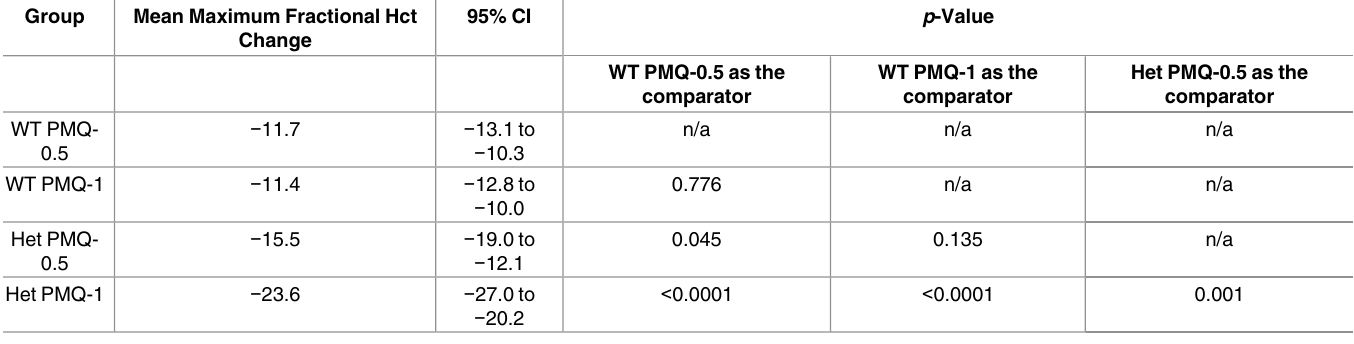
Table 2. Comparison of the mean maximum individual fractional haematocrit reductions between G6PD heterozygous and wild-type females tak- ing PMQ-1 or PMQ-0.5 not adjusted for initial parasitaemia. Group Mean Maximum Fractional Hct 95% Change